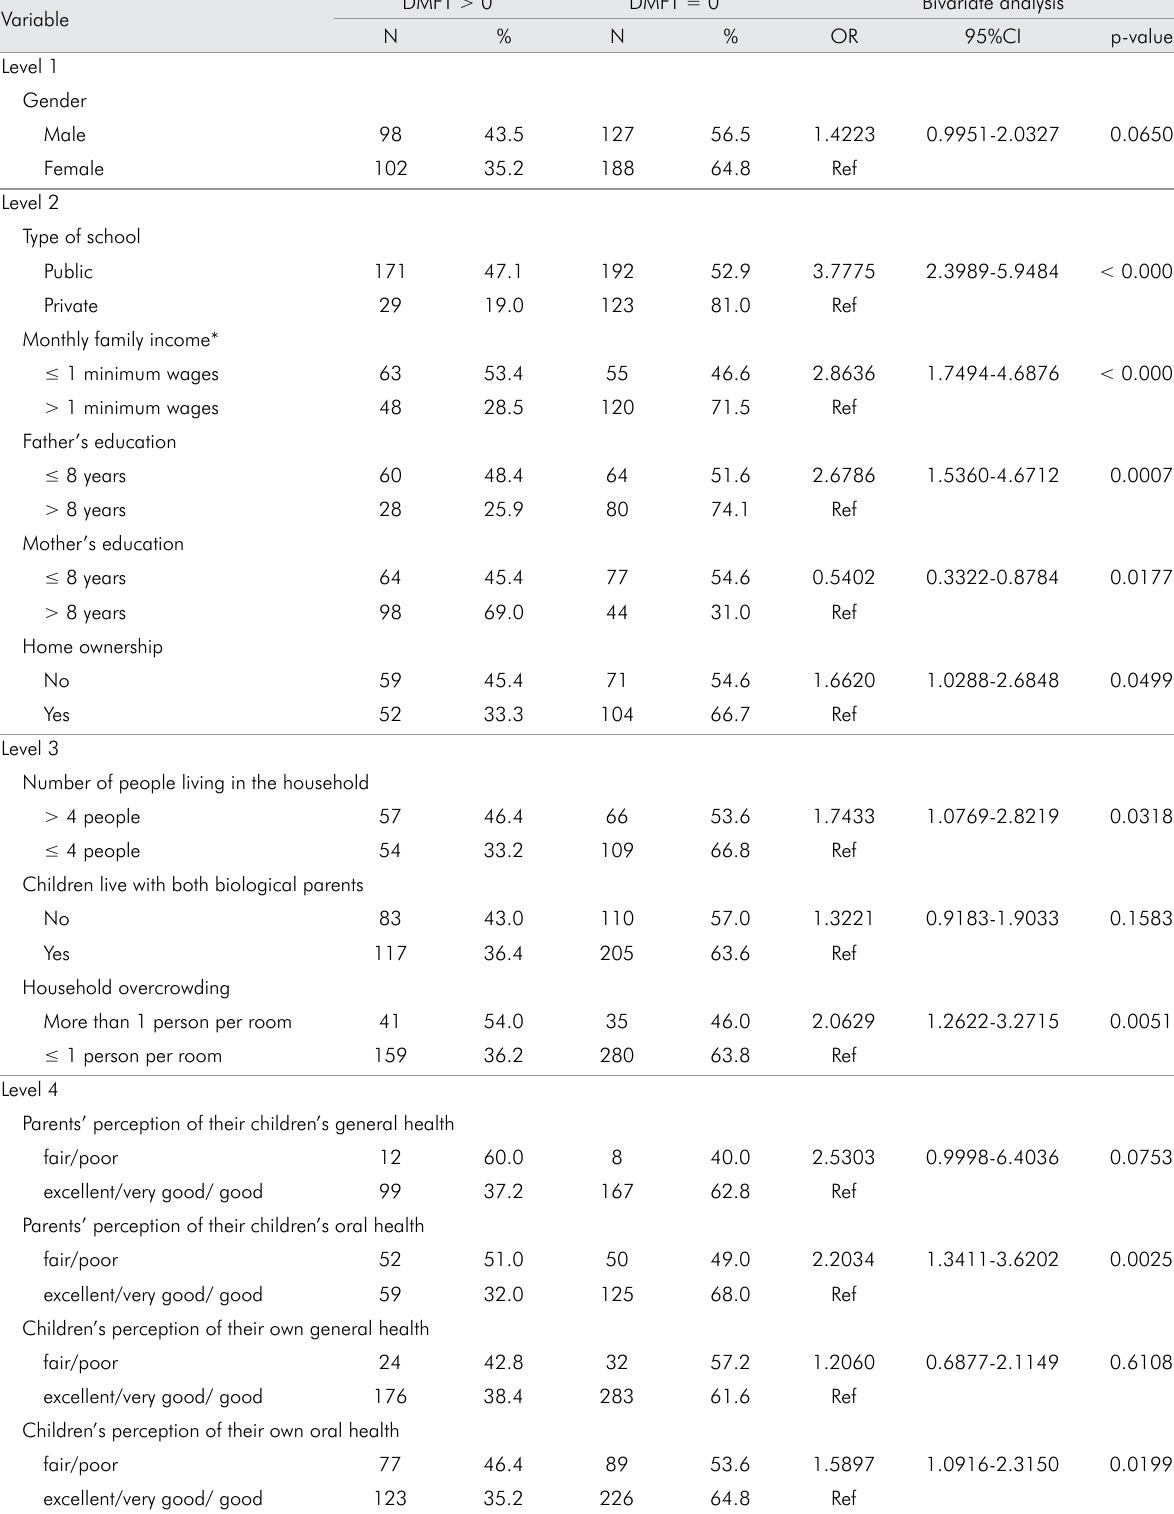
Table 1. Bivariate analysis of the association of social determinants with caries